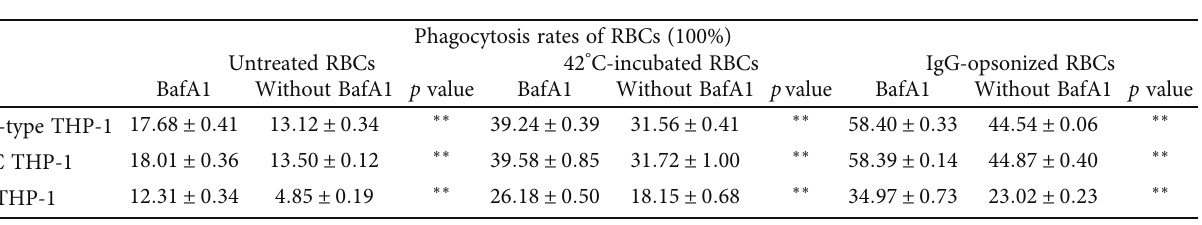
Table 2: Engulf ability of THP-1 cells to erythrocytes is enhanced using BafA1.